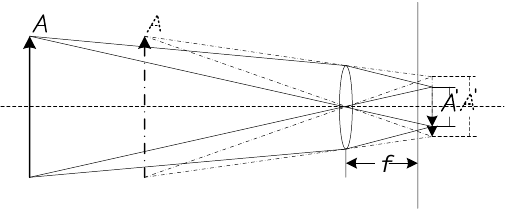
Figure 1. Imaging principle of the human eye.